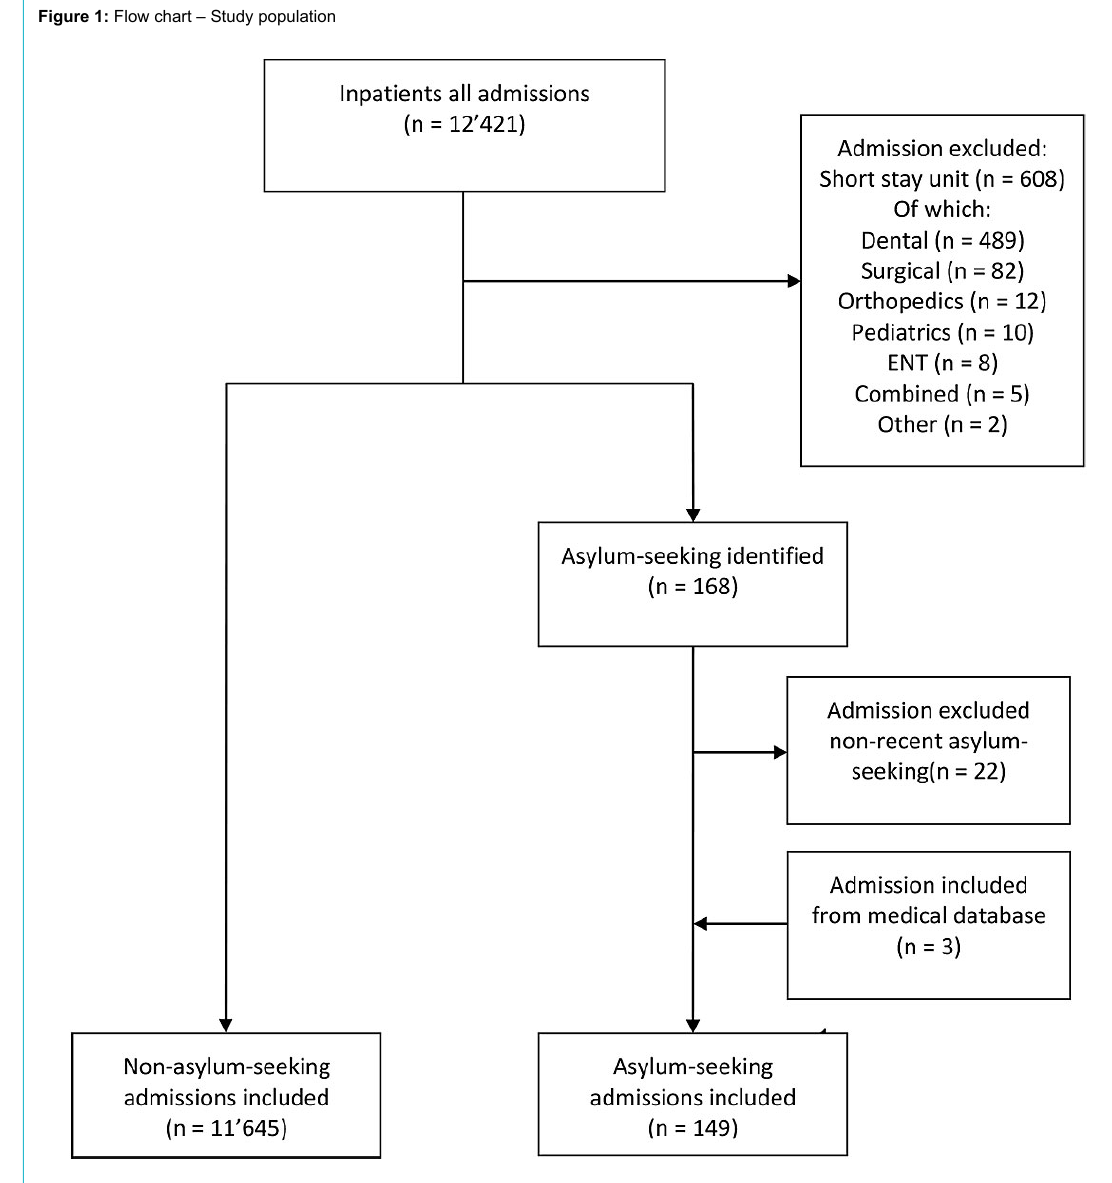
Figure 1: Flow chart – Study